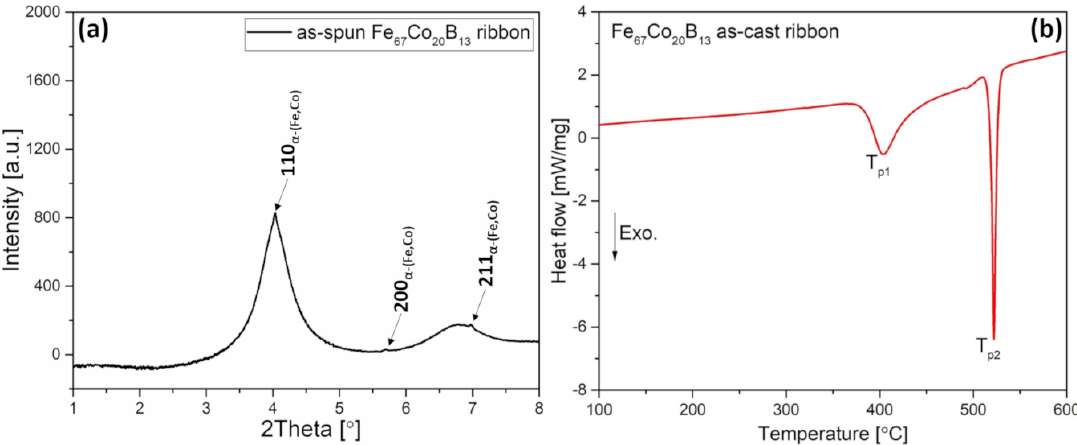
Figure 1. ( a ) High-energy X-ray diffraction pattern and ( b ) differential scanning calorimetry curve recorded during heating for as-spun Fe 67 Co 20 B 13